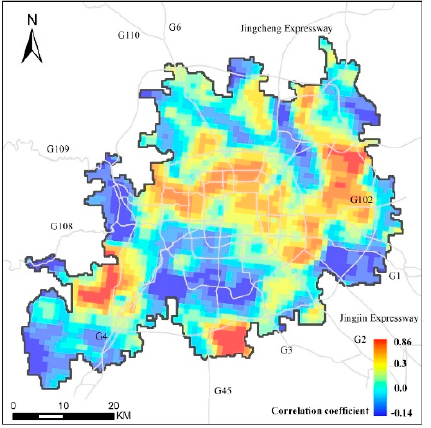
Figure 11. Correlation coefficients at grid level across our study area.